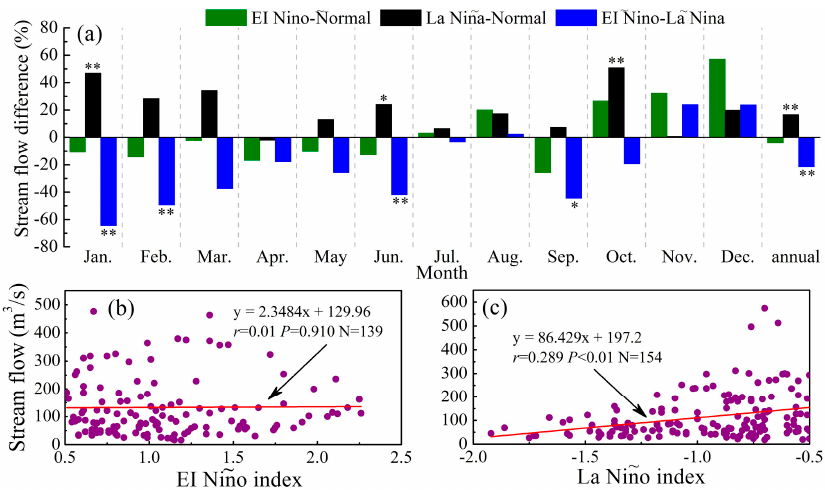
Figure 9. Monthly and annual stream flow changes in El Niño and La Niña year ( a ); and the relationships between monthly stream flow and ENSO events (EI Niño index and La Niño index) during 1961–2012 in the Poyang Lake Basin ( b , c ). The asterisks upon the bar indicate the statistical significance based on independent samples t test (* significant at P ≤ 0.1; ** significant at P ≤ 0.05).